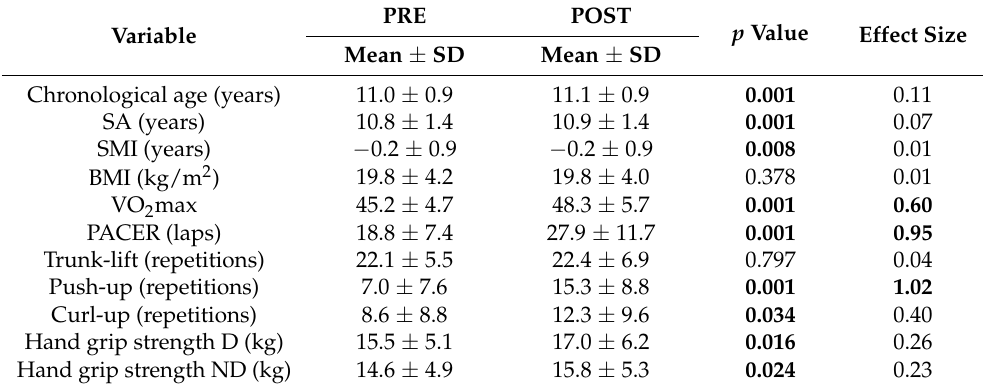
Table 2. The fitness and maturation variables before and after the intervention across the whole group (girls and